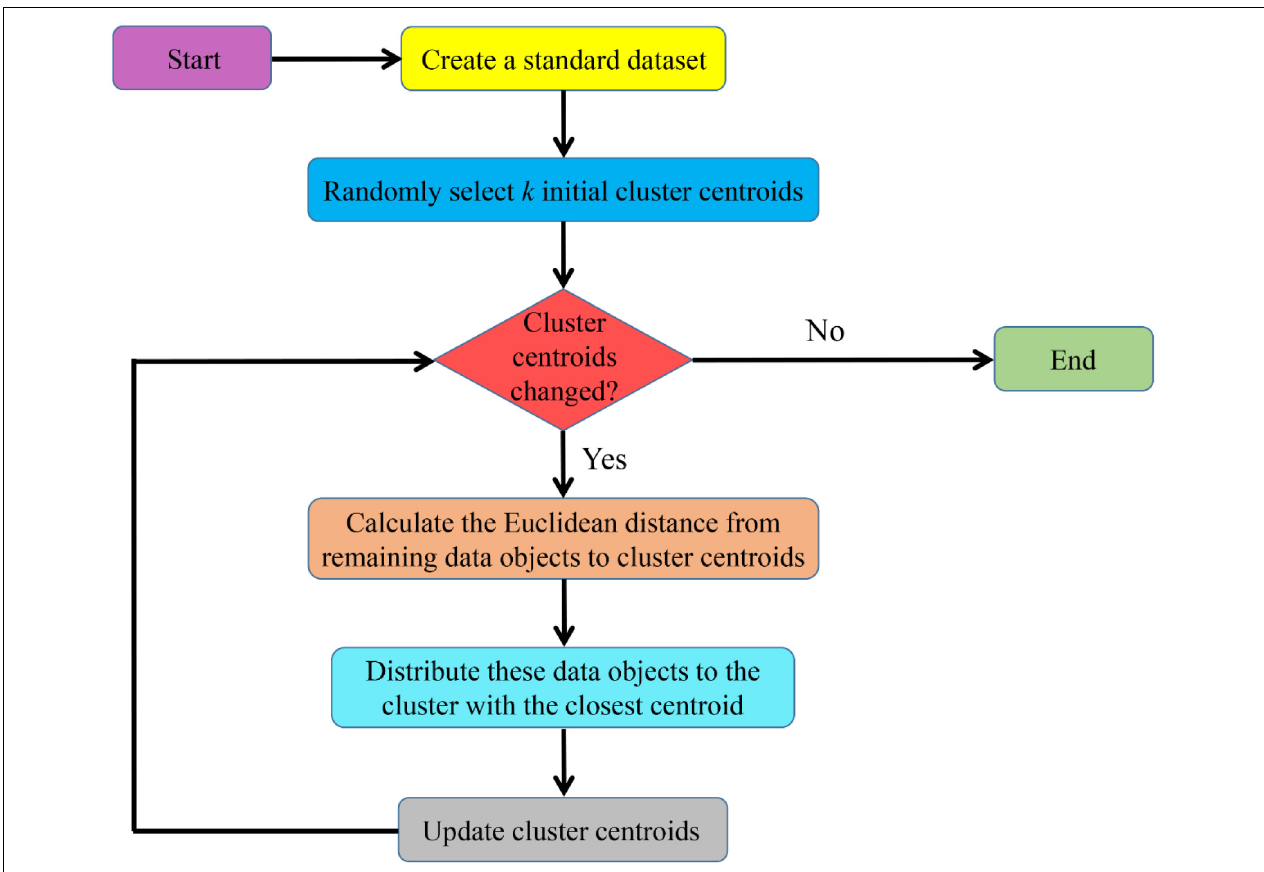
FIGURE 6 | The workflow of the K-means clustering algorithm. This algorithm needs to select k initial cluster centroids in advance. Then, the positions of cluster centroids are continuously updated according to the similarity between data objects and these positions. When updated cluster centroids no longer change or the objective function converges, the iteration ends, and the final result can be